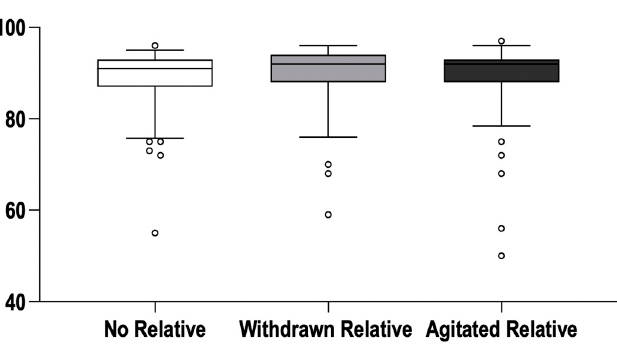
Figure 2. Primary outcome parameter (“Hands-on time”). Box and whisker plot of the percentage hands-on time. Boxes represent medians and interquartile range; whiskers delineate the 10th and 90th percentile, respectively; circles denote values outside the range from 10th to 90th percentile. There was no significant difference between the groups. Family presence had no effect on hands-on time (91% [87–93] for “control” vs. 92% [88–94] for “withdrawn” and 92 [88–93] for “agitated” relatives; p = 0.15).